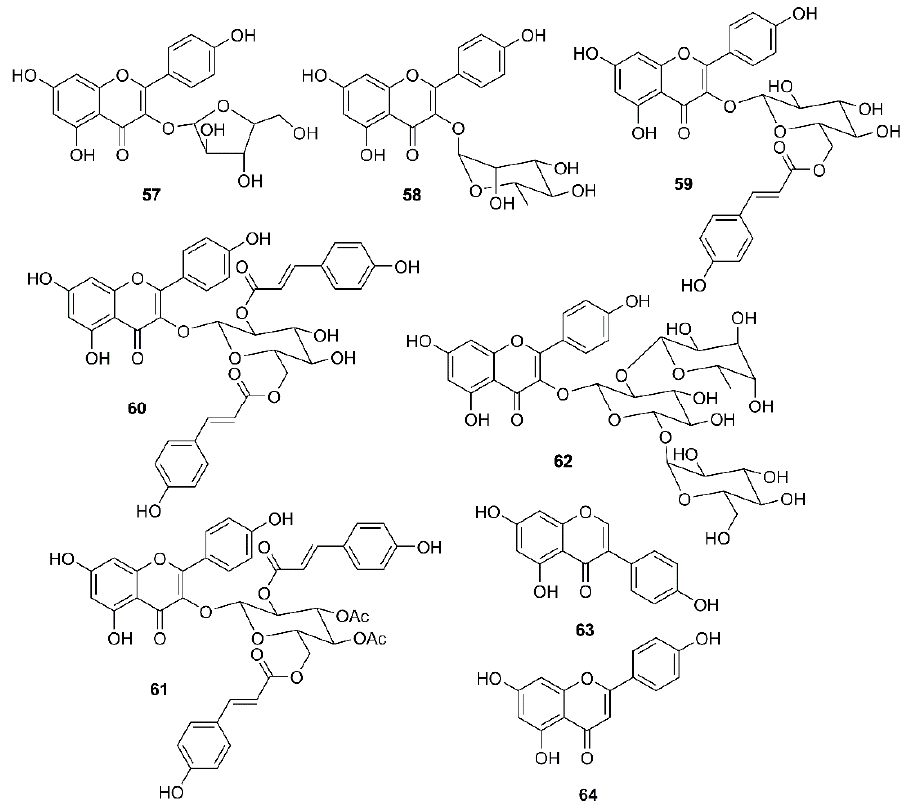
Figure 9. Structure of flavonoids, flavonoid glycosides and an isoflavonoid 57 – 64 . As part of an investigation to search for botanical sources for SARS-CoV 3CL pro inhibitors, Ryu et al. have found that biflavones, named amentoflavone ( 65 ), bilobetin ( 66 ), ginkgetin ( 67 ), and sciadopitysin ( 68 ) (Figure 10), isolated from a medicinal plant Torreya nucifera L. Siebold and Zucc. (Lamiaceae), exhibited an inhibitory effect against SARS-CoV 3CL pro . However, 65 was the most potent non-competitive anti-SARS-CoV 3CL pro with an IC 50 value of 8.3 µ M. Compound 65 is 30-fold more potent as SARS-CoV 3CL pro inhibitor than the parent compound apigenin ( 64 ) (Figure 9) (IC 50 = 280.8 µ M), whereas 22 and 23 , whose IC 50 values were 23.8 and 20.2 µ M, respectively, were less potent than 65 . Furthermore, the authors have also attempted to elucidate the interaction of SARS-CoV 3CL pro with 65 by using a three-dimensional structure of SARS-CoV 3CL pro in complex with a substrate-analogue inhibitor (coded 2z3e)24, obtained from the Protein Data Bank for modeling analysis. Computer docking analysis revealed that 65 nicely fits in the binding pocket of 3CL pro . The hydroxyl group on C-5 of 65 formed two hydrogen bonds with the nitrogen atom of the imidazole ring of His-163 (3.154 Å) and a hydroxyl group of Leu-141 (2.966 Å), both belonging to S1 site of 3CL pro , whereas the hydroxyl group in the B ring of 65 forms hydrogen bonds with Gln-189 (3.033 Å), belonging to S2 site of 3CL pro . These structure-activity relationships studies implied that interactions with Val-186 (4.228 Å) and Gln-192 (3.898 Å) are one of the key chemotypes in this inhibitor. Furthermore, the potencies of 65 and 66 correlated well with their binding energies viz 65 = 11.42 kcal/mol, and 64 = 7.79 kcal/mol. The difference in binding energy could explain the reason why the IC 50 value of 65 against 3CL pro is 30-fold smaller than that of 64 (Table 2)